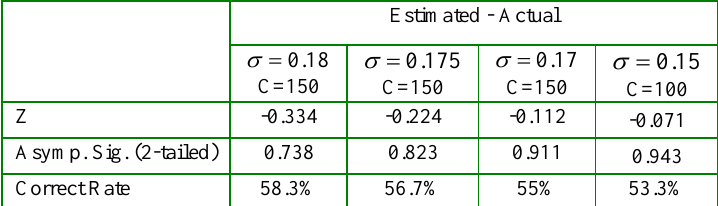
Table 5. Wilcoxon Signed Ranks Tests for different SVM parameters with